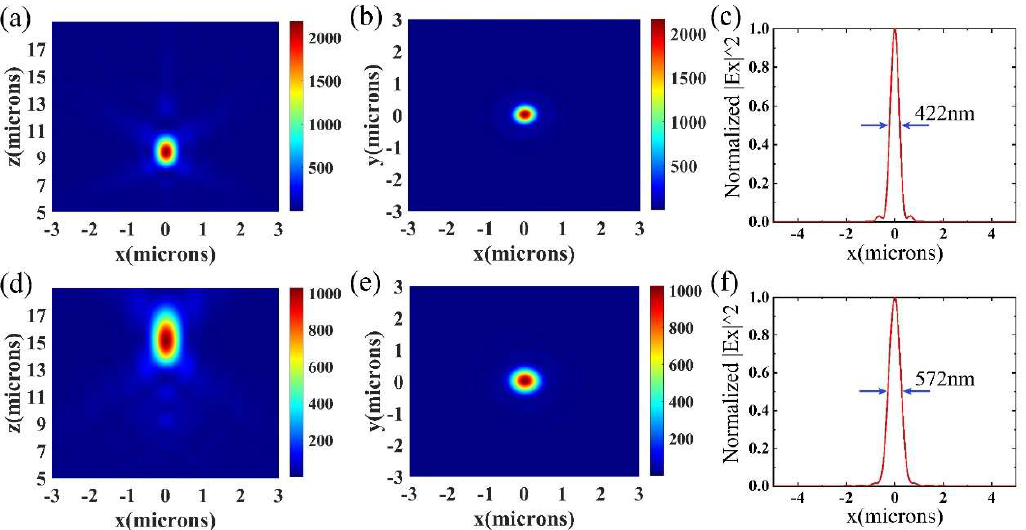
Figure 5. The simulated results for the refractive index of BTO was 2.4 and 3.07. ( a , d ) The intensity distribution of the first focal point (when n = 2.4) and the second focal point (when n = 3.07) on the x–z plane; ( b , e ) the intensity distribution of the first focal point and the second focal point on the x–y plane; ( c , f ) the full width at half-maxima of the first focal point (f 1 ) and second focal point (f 2 ) were 422 nm and 572 nm.